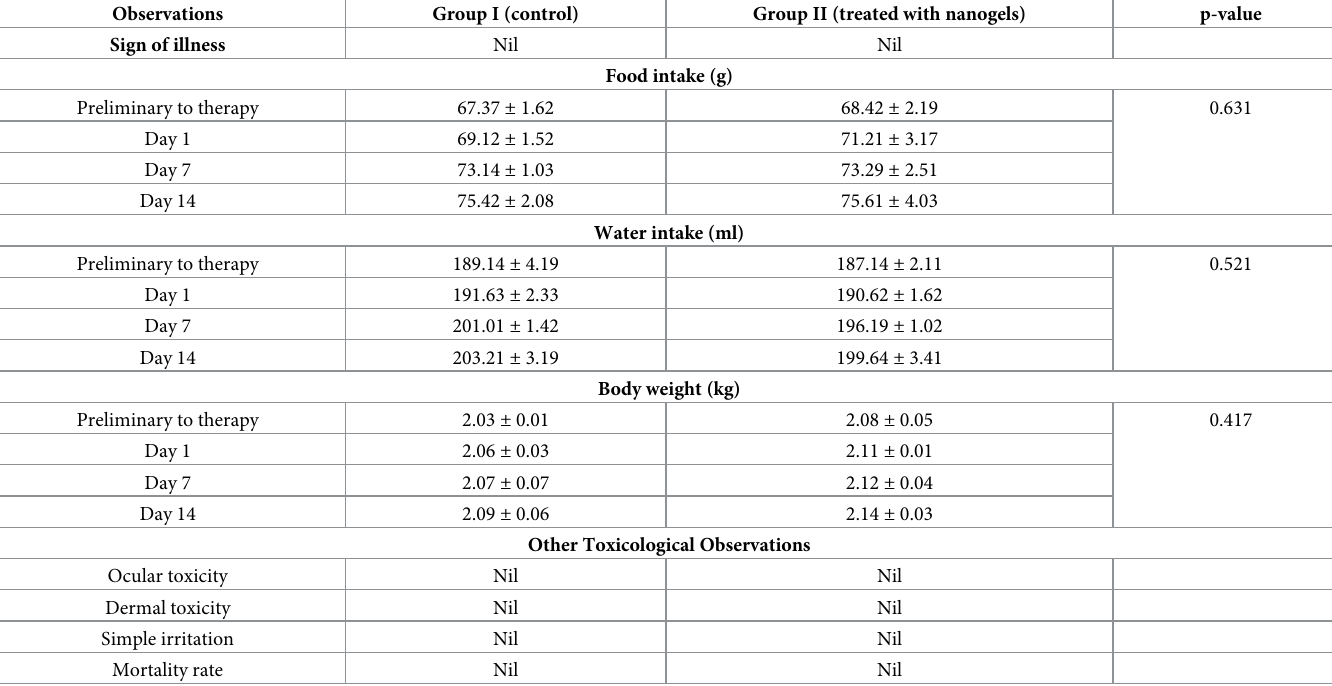
Table 5. Clinical observations of an acute oral toxicity study for β CD/PVP-co-poly (AMPS) nanogels.